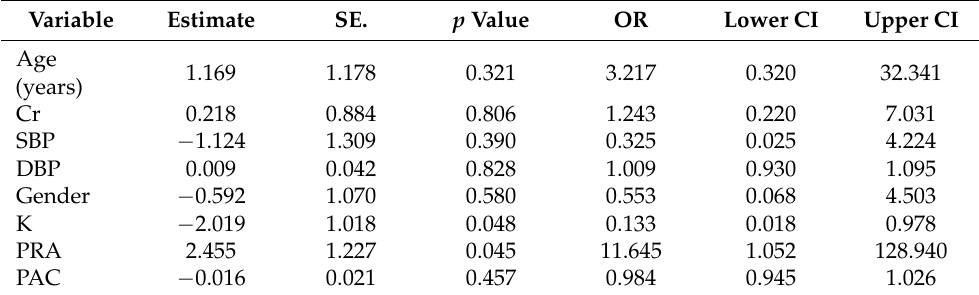
Table 4. The association of pre-operative variables predicting hypertension-remission in GRA patients (N = 36) after adrenalectomy by logistic